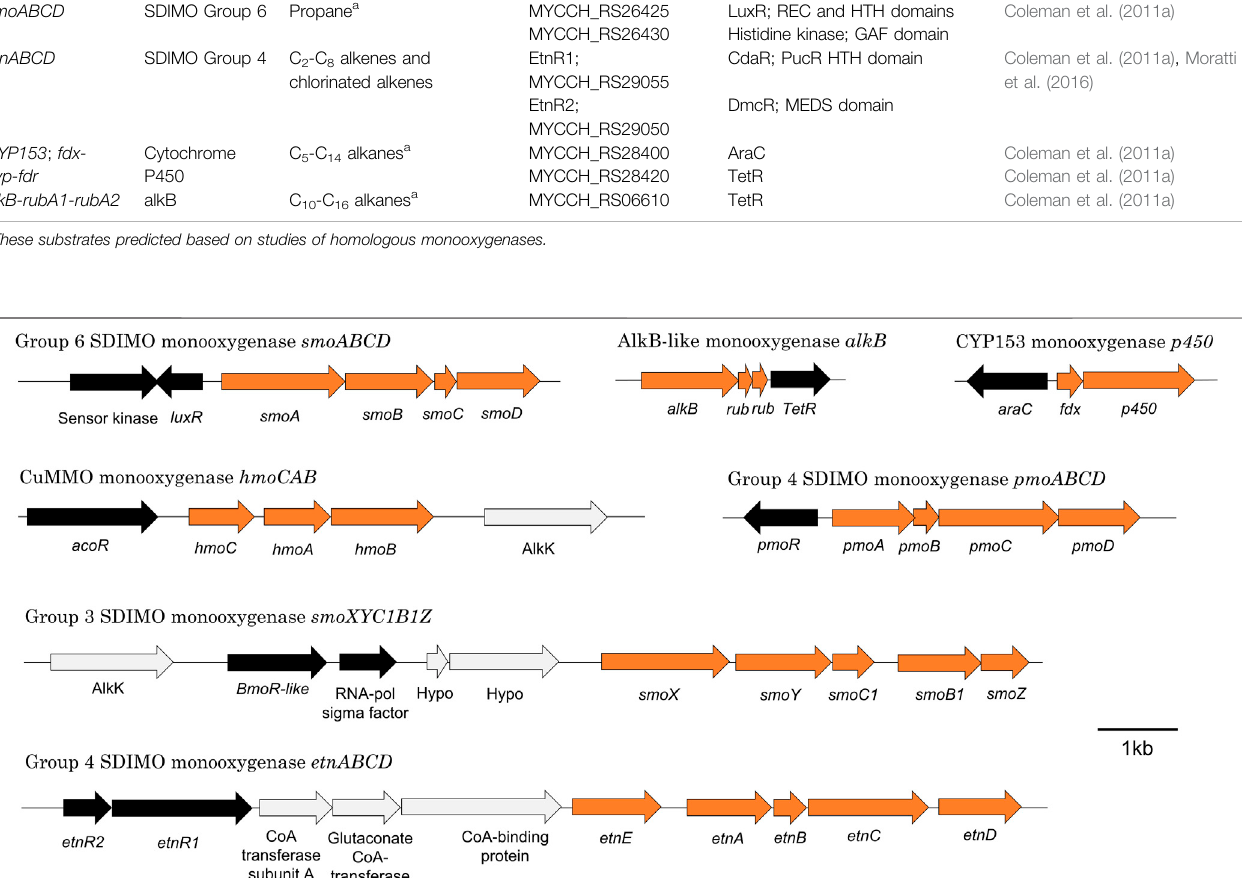
Frontiers in Bioengineering and Biotechnology |